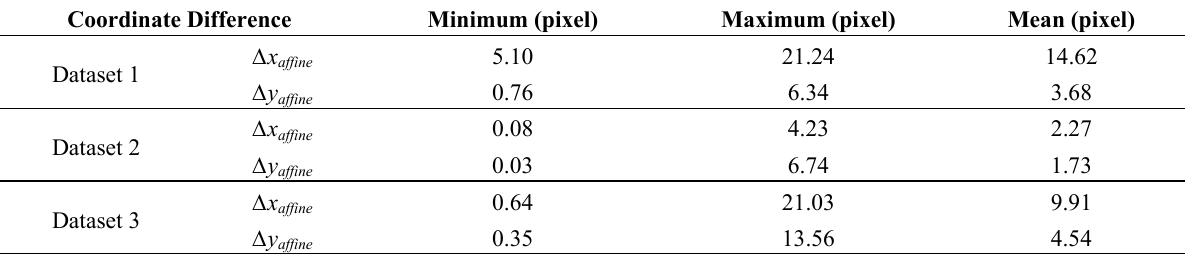
Table 4. Statistics of coordinate differences between estimated and observed values.